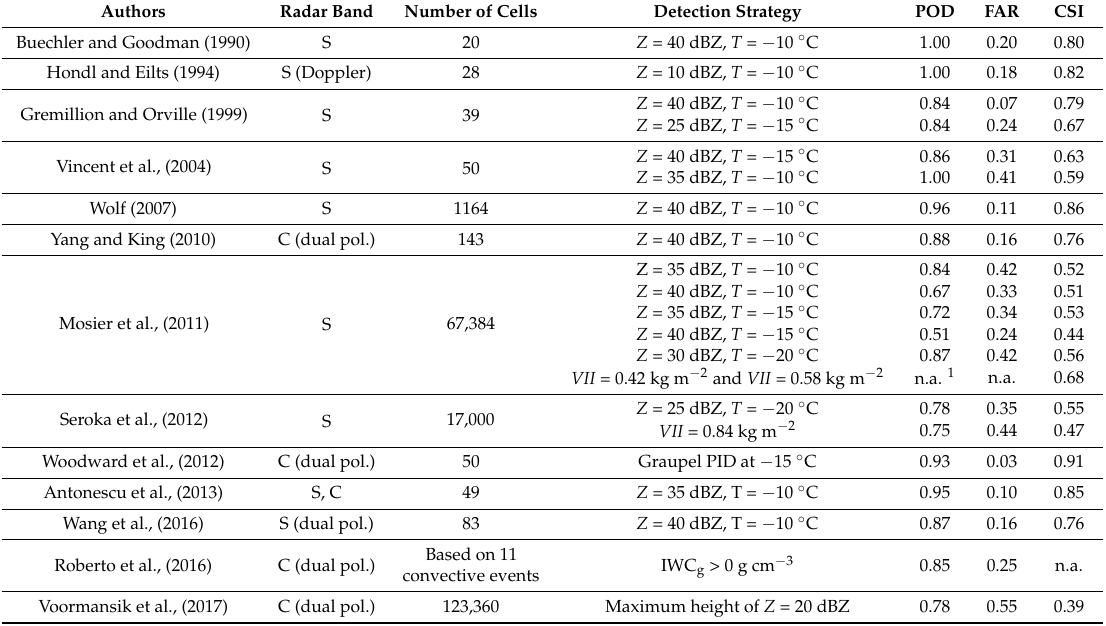
Table 1. Results from previous studies of stroke nowcasting using radar-based predictors. For all the studies T (isotherm level) is the environmental temperature, with the only exception of Wolf (2007), where T is the updraft